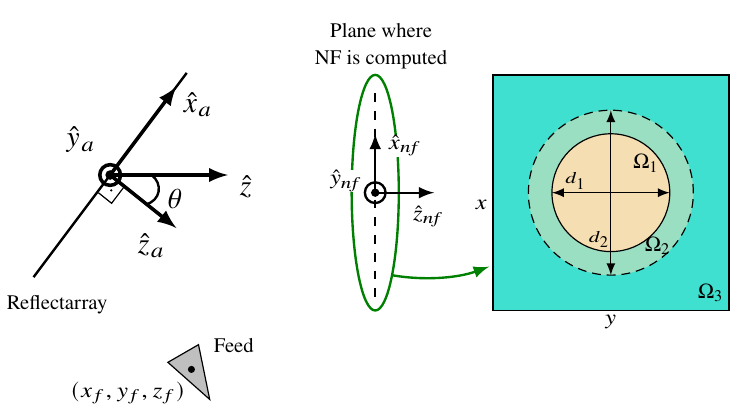
Figure 3. Schematic representation of the antenna optics. The NF plane is tilted θ = 20° with regard to the reflectarray and is divided into three regions. The FoM are defined in region Ω 1 , while region Ω Ω 2 defines a transition and 3 comprises the rest of the